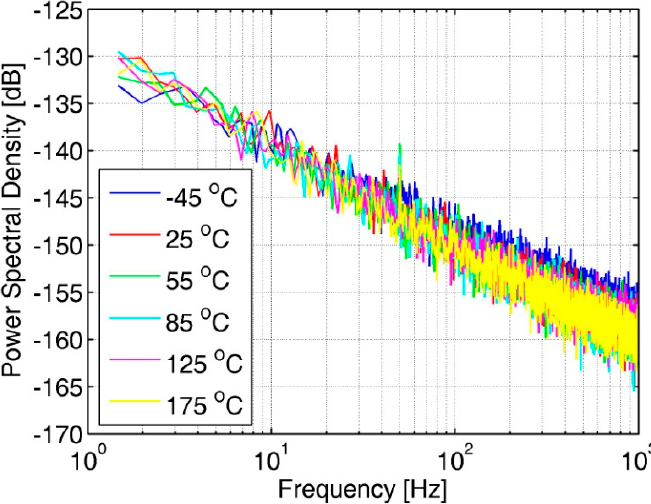
Figure 9. Noise PSD of the OTA in the analog front-end at various temperature points.